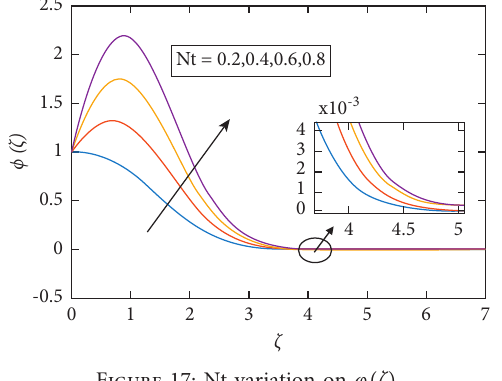
Figure 20: σ variation on φ ( ζ ) .